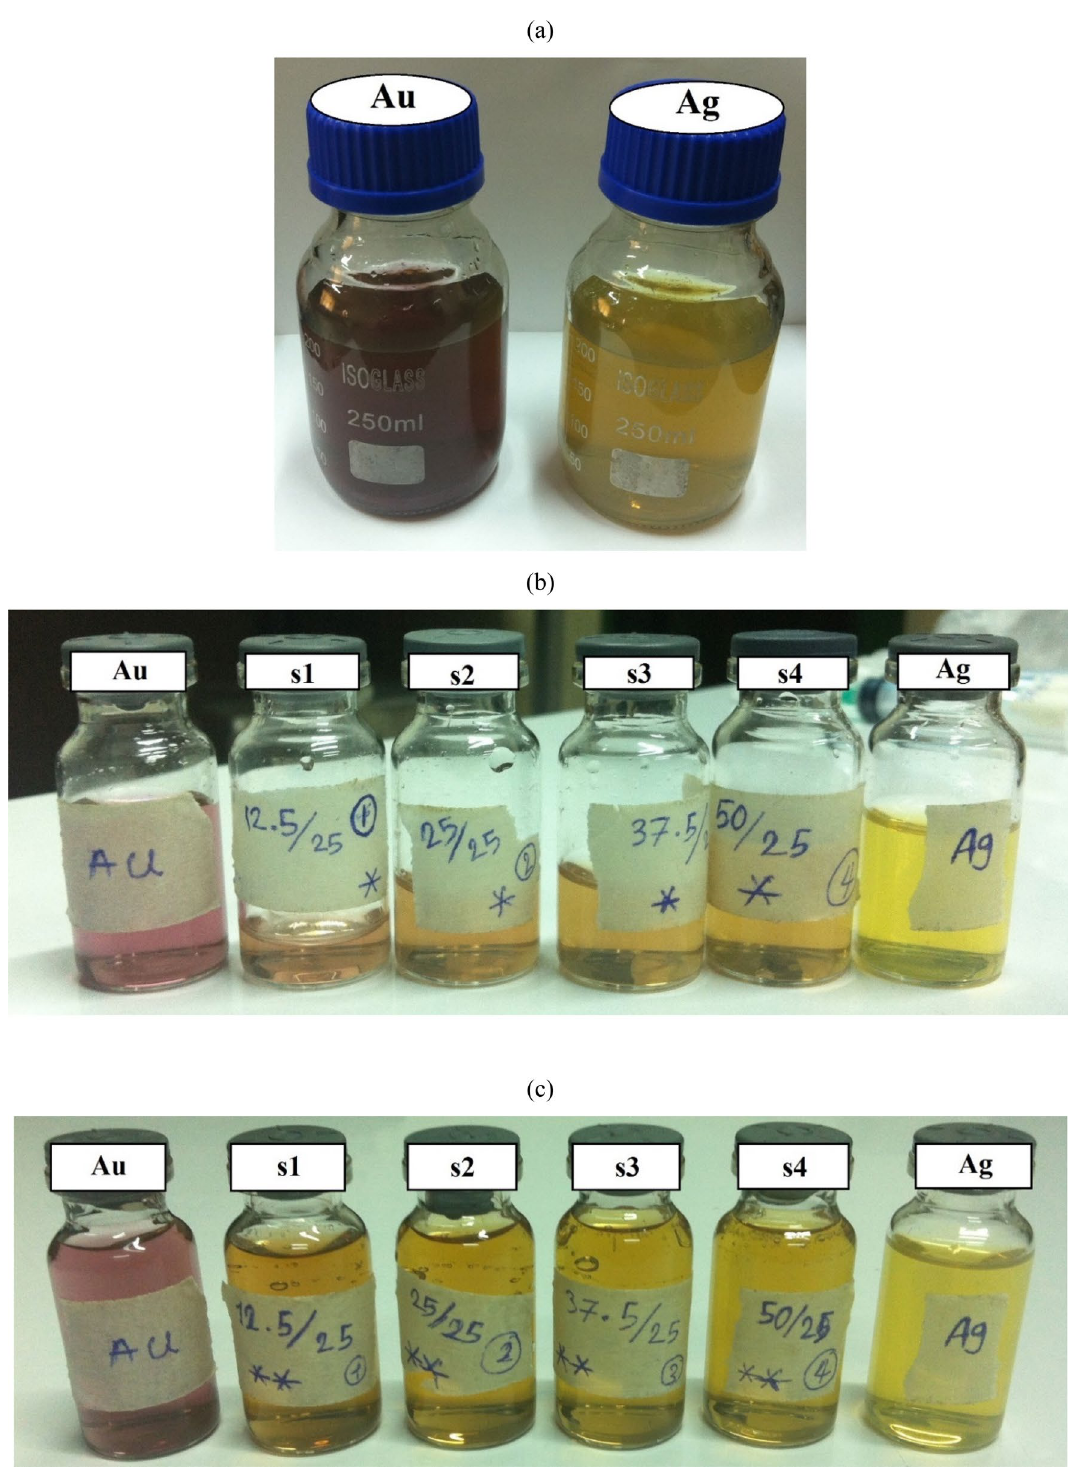
Fig. 1 Gold and silver nanoparticles formatted by irradiation of 1064 nm wavelength a , Au and AgNPs suspensions beside their mixtures before green laser irradiation b and Au/Ag BNPs with different volumetric ration after green laser irradiation